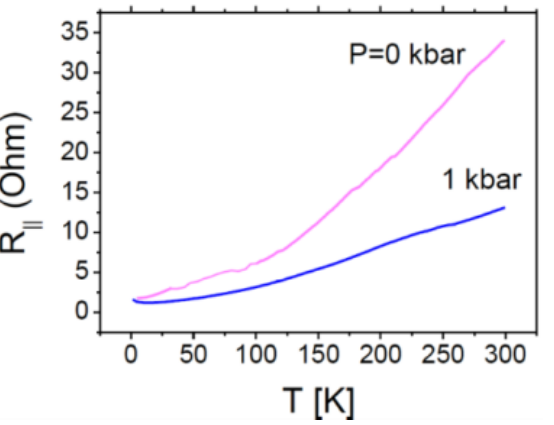
Figure 10. ( a ) Temperature dependence of the resistivity of the κ -(BDH-TTP) 4 ReF 6 sample ( 1 ) measured in the conducting plane and ( b ) perpendicular to it at different pressures; ( c )The temperature dependence of the resistivity anisotropy of ( 1